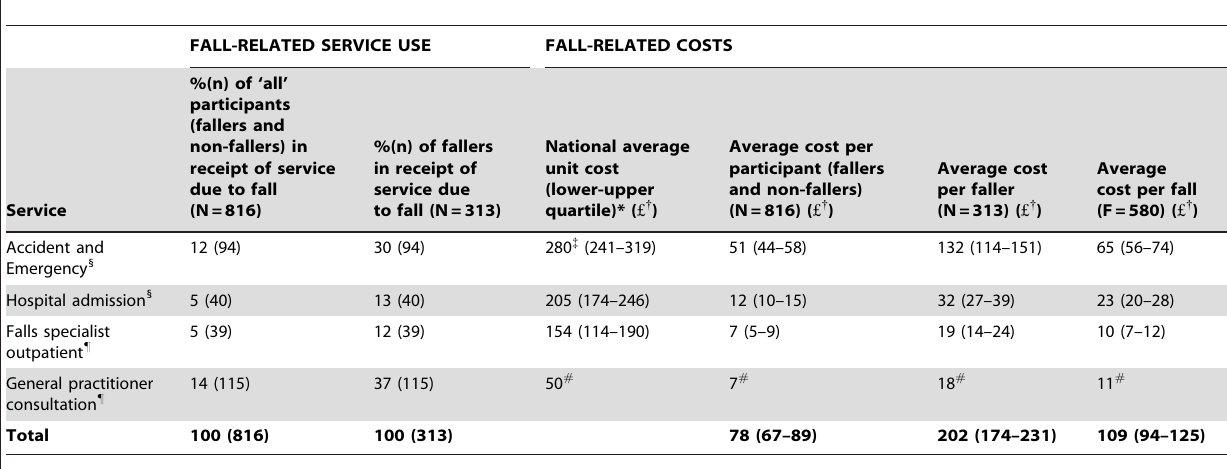
Table 3. Health service use and 12 month cost of falls.